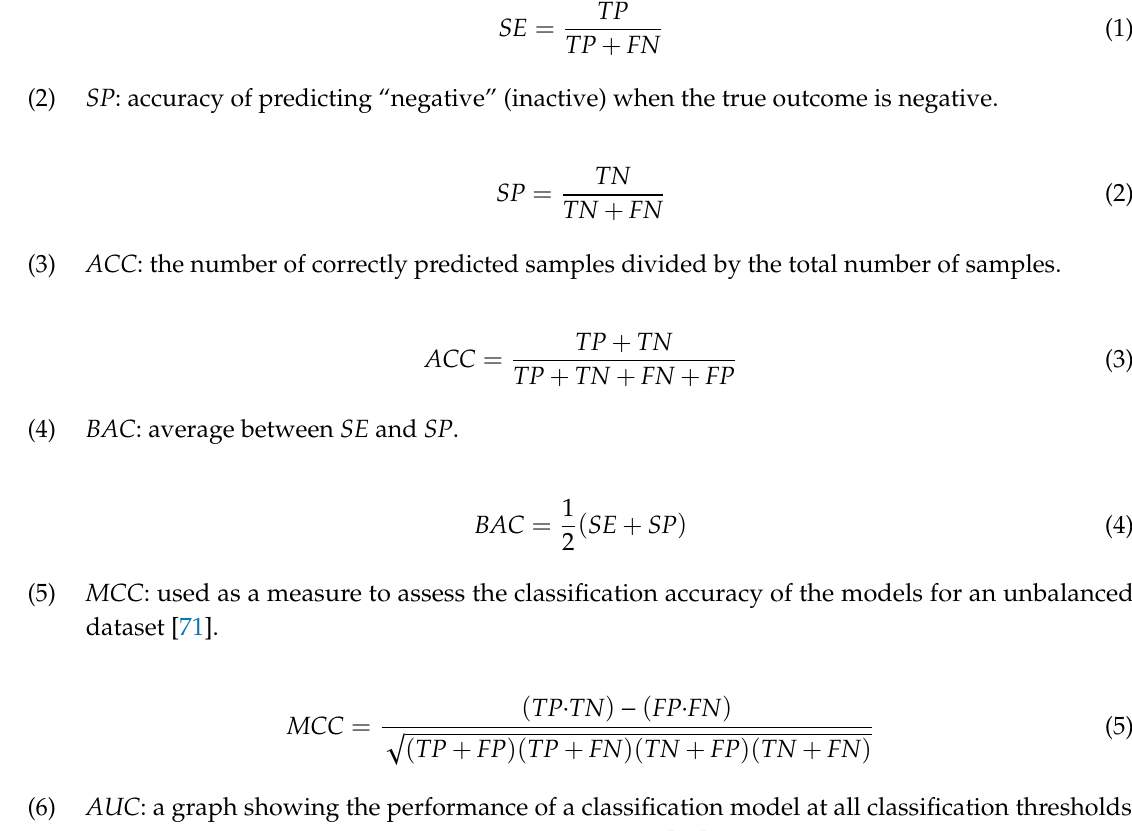
AUC : a graph showing the performance of a classification model at all classification thresholds. This curve plots two parameters: (i) SE and (ii) 1– SP